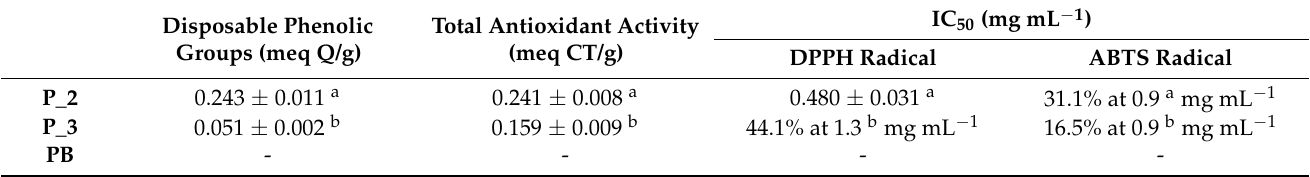
Table 2. Antioxidant performances of pectin conjugates. Disposable